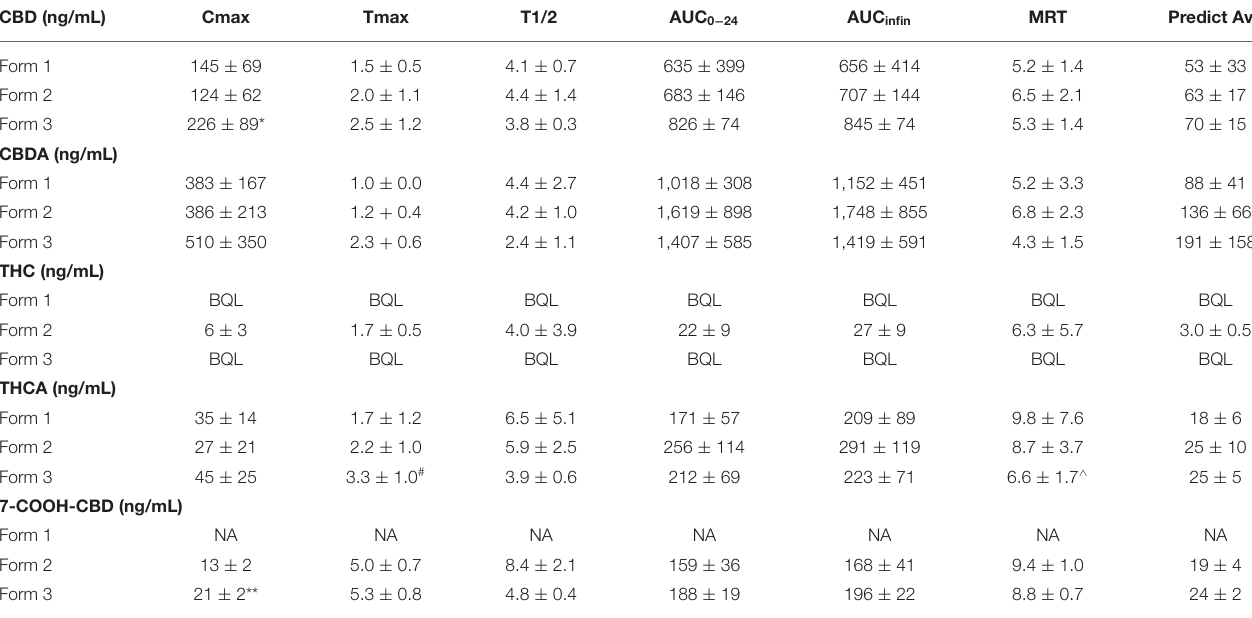
TABLE 1 | Mean and SEM ( n = 6 for all cannabinoids) on serum 24- pharmacokinetics values of CBD, CBDA, THC, THCA, and 7-COOH-CBD. CBD (ng/mL) Cmax Tmax T1/2 AUC 0 − 24 AUC infin MRT Predict